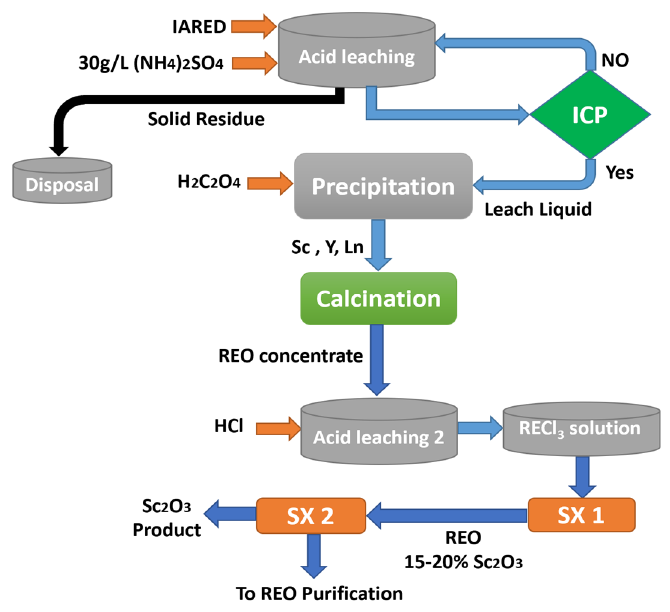
Figure 7. A flow-chart for scandium recovery from IARED, adapted from [71].